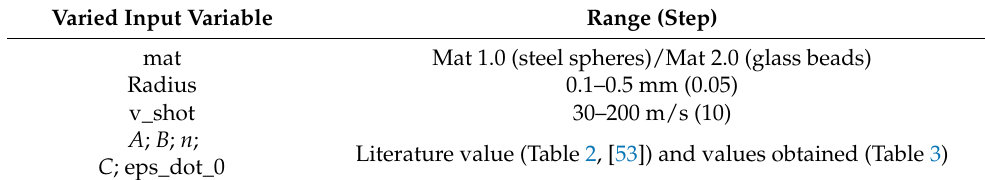
Table 5. Varied variables within this case study.